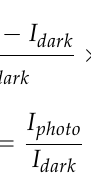
Figure 13. The photocurrent versus time of ( a ) porous Si and ( b ) AgNWs/porous Si photo-sensors for four bias voltages of 1V, 2V, 3V, and 4V.